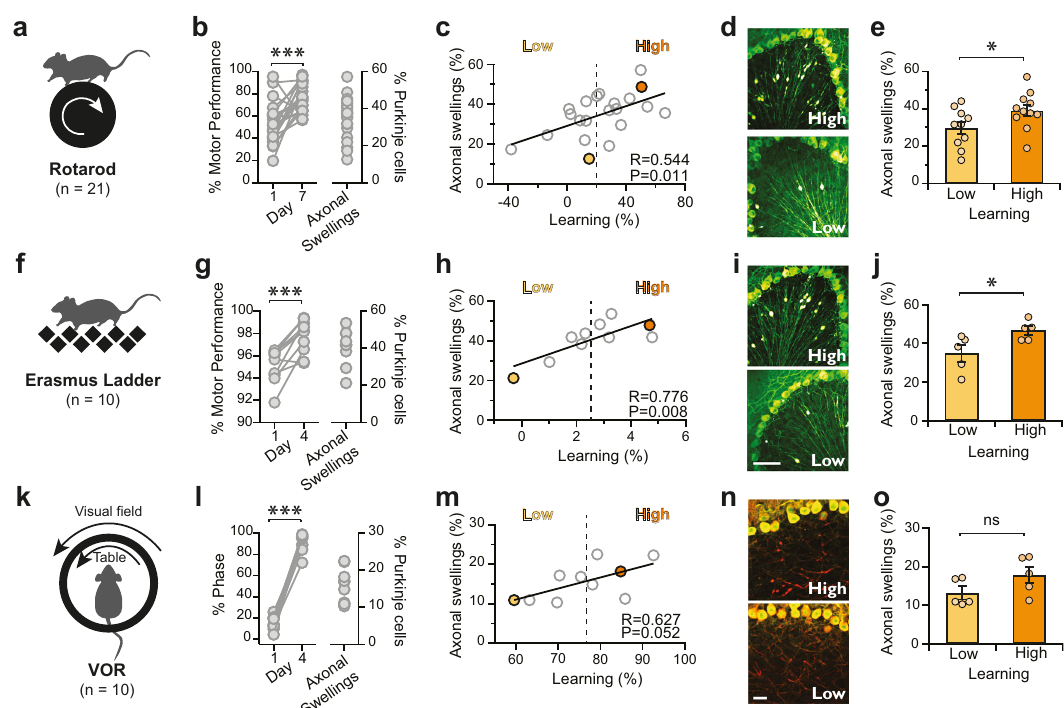
Fig. 6 Axonal swelling density is positively correlated with cerebellar-related learning. a Rotarod assay. b Variability in motor learning (left; two-tailed paired Student ’ s t- test, P < 0.001) and the density of axonal swellings in anterior vermis lobule III (right) across mice. c The variability in motor learning is positively correlated with the density of axonal swellings (two-tailed Pearson correlation, R = 0.544, P = 0.011). The fi lled orange marker indicates representative high learner in ( d ), while the yellow marker indicates the low learner in ( d ). d Representative images of anterior cerebellar vermis from high learners (top) and low learners (bottom). Note the differences in the number of axonal swellings. e When mice are separated into high and low learner groups (Low learners, N = 10 animals; High learners, N = 11 animals; two-tailed Student ’ s t -test, P = 0.046), they have signi fi cantly different numbers of axonal swelling, with high learners having more than low learners. f Erasmus ladder assay. g Variability in motor learning (left; two-tailed paired Student t- test, P = 0.001) and anterior lobule swelling density (right) are also observed with Erasmus ladder. h This variability is positively correlated across animals (two-tailed Pearson ’ s correlation, R = 0.776, P = 0.008). i Representative images from high (top) and low (bottom) learners on the Erasmus ladder assay. j High learners on Erasmus ladder show more axonal swellings in lobule III of the vermis than low learners (Low learners, N = 5 animals; High learners, N = 5 animals; two-tailed Student ’ s t- test, P = 0.039). k VOR assay. l Some but less variability in learning is observed in VOR (left; two-tailed paired Student ’ s t- test, P < 0.001) and in the density of axonal swellings in the fl occulus (right). m Variability in learning and axonal swelling density in the fl occulus is correlated across animals for VOR (two-tailed Pearson ’ s correlation, R = 0.627, P = 0.052). n Representative images showing axonal swellings (stained with IP3R) in high learners (top) and low learners (bottom) for VOR task. o The density of axonal swellings in the fl occulus is not signi fi cantly different in low and high VOR learners (Low learners, N = 5 animals; High learners, N = 5 animals; two-tailed Student ’ s t -test, P = 0.122), perhaps because only a subset of swellings are labeled with IP3R, although the same trend is observed as for the Rotarod and Erasmus ladder tasks. Data were presented as mean ± SEM (*** P < 0.005, * P < 0.05; ns P > 0.05). Source data are provided as a Source Data fi